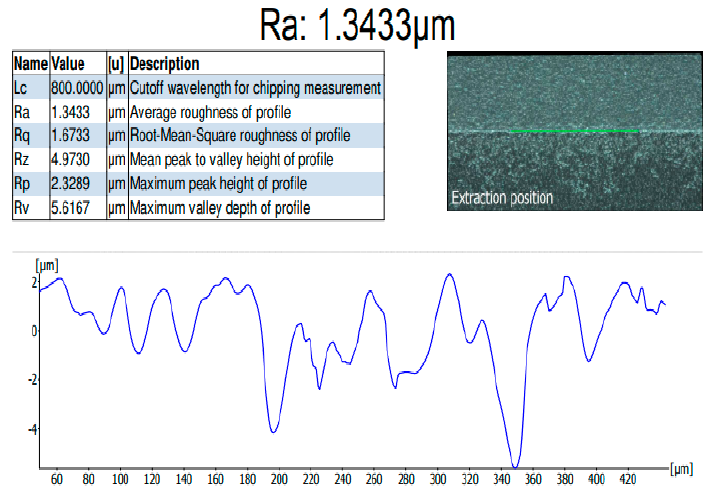
Figure 9. Example of measured parameters of cutting edge arithmetic mean deviation of the assessed profile Ra (EDM sharpening). Table 5. Experimental plan matrix.